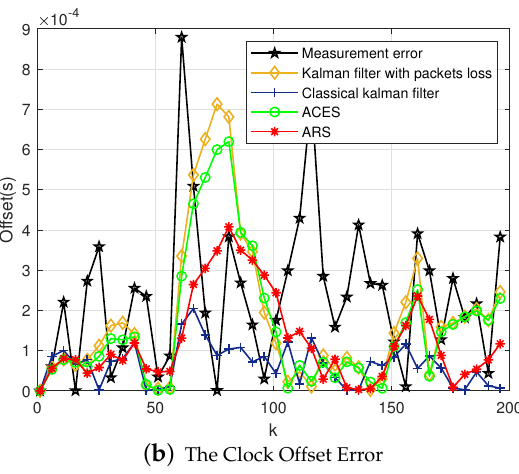
Figure 12. Clock Offset Error and Variance of the First-order Kalman Filter in Multi-hop Networks.